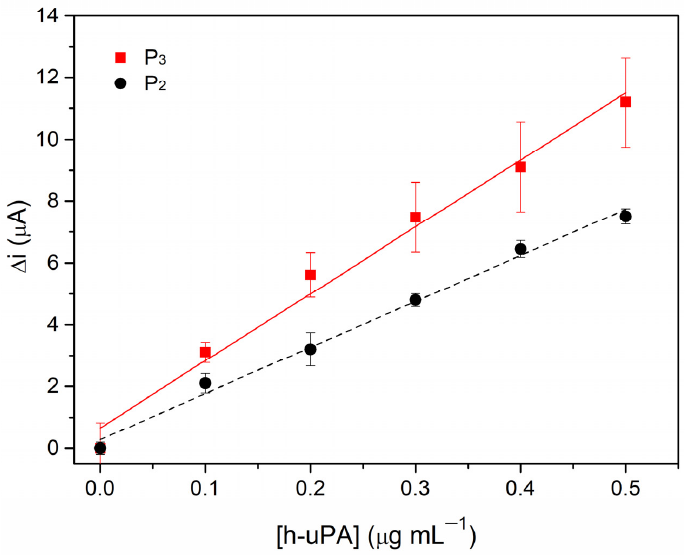
Figure 3. Comparison of the calibration plots of h-uPA obtained via sandwich-type affinity assay using P 2- (black full circles) or P 3- (red full squares) modified-MB. The values shown are the average of triplicate measurements with the associate error calculated as the standard deviation. The linear fi tt ing equations for P 2 (dashed black line): y = 16.0 ± 0.9x + 0.28 ± 0.07 and P 3 (red full line): y = 21.7 ± 1.3x + 0.67 ± 0.39.